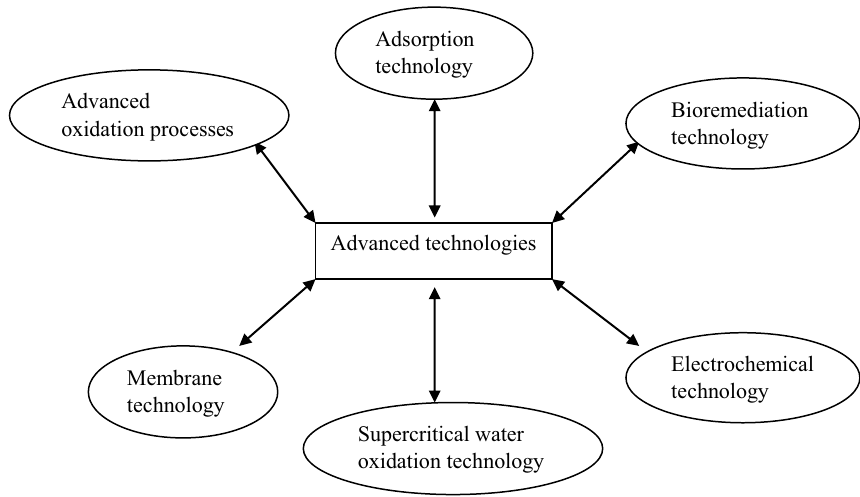
Fig. 2 Schematic diagram depicting advanced technologies for the treatment of industrial oily